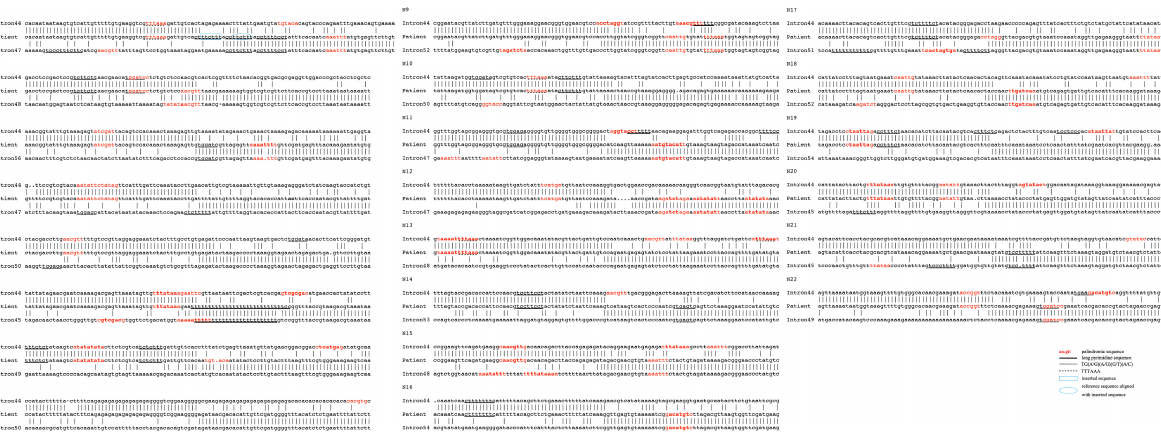
junctions in patients with deletions starting from intron 44 based on third-generation long-read sequencing, leading to proposals of potential mechanisms of large deletion of